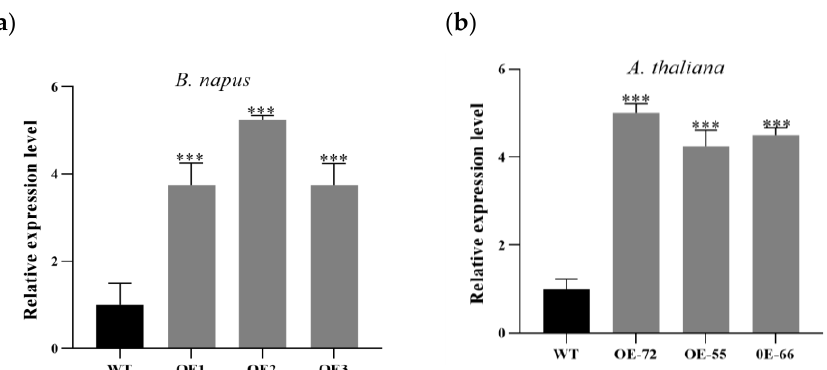
Figure 2. The expression of BnKAT2 in transgenic B. napus ( a ) and A. thaliana ( b ) , relative to their respective wild-type expression levels. Values are means ± SD of three independent biological rep- licates. *** indicate significant differences at the 0.001 levels.